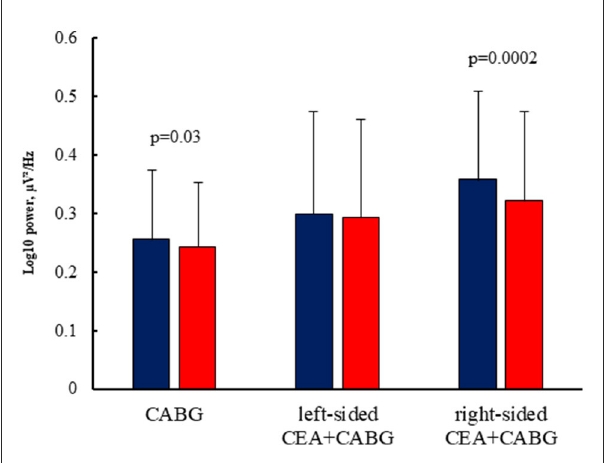
FIGURE4 Lateral differences of theta1 power in the patients undergoing isolated CABG and simultaneous intervention (CABG + CEA). Blue columns—the power values in the left hemisphere, and red columns—the power values in the right hemisphere.